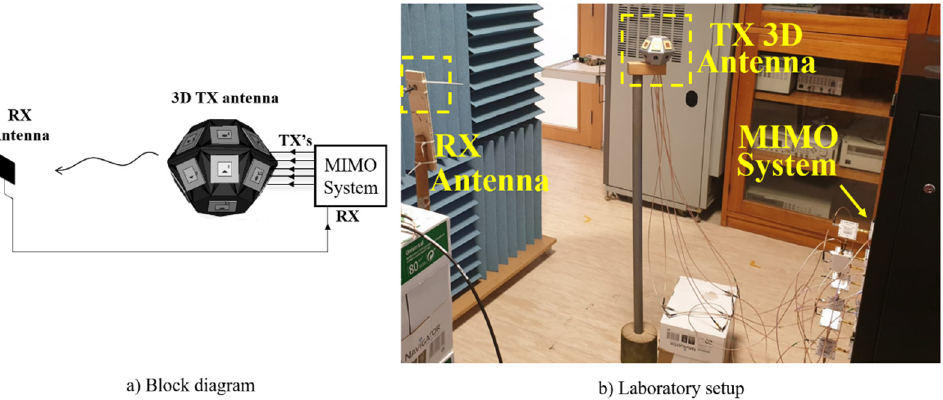
Figure 7. OTA multi-sine characterization to identify the contribution of each antenna element for case A (upper band.): ( a ) block diagram and ( b ) laboratorial setup.